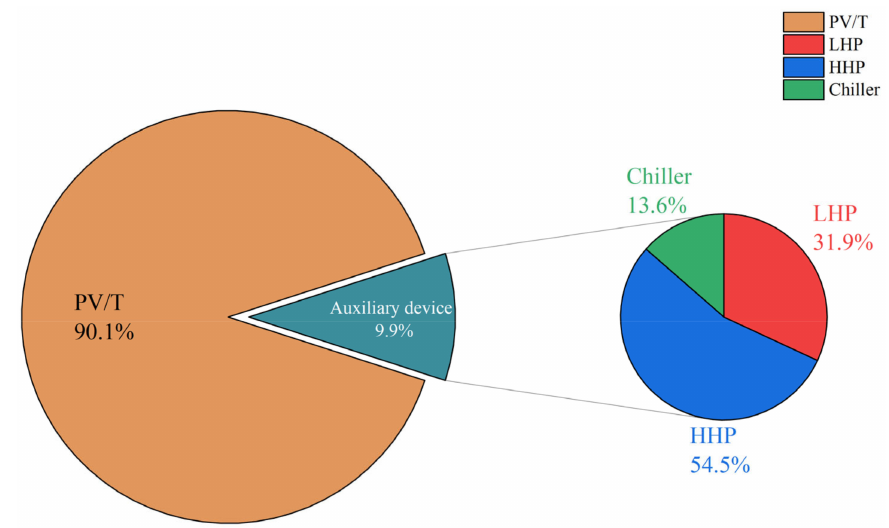
Figure 15. Exergy flow stream process of system.